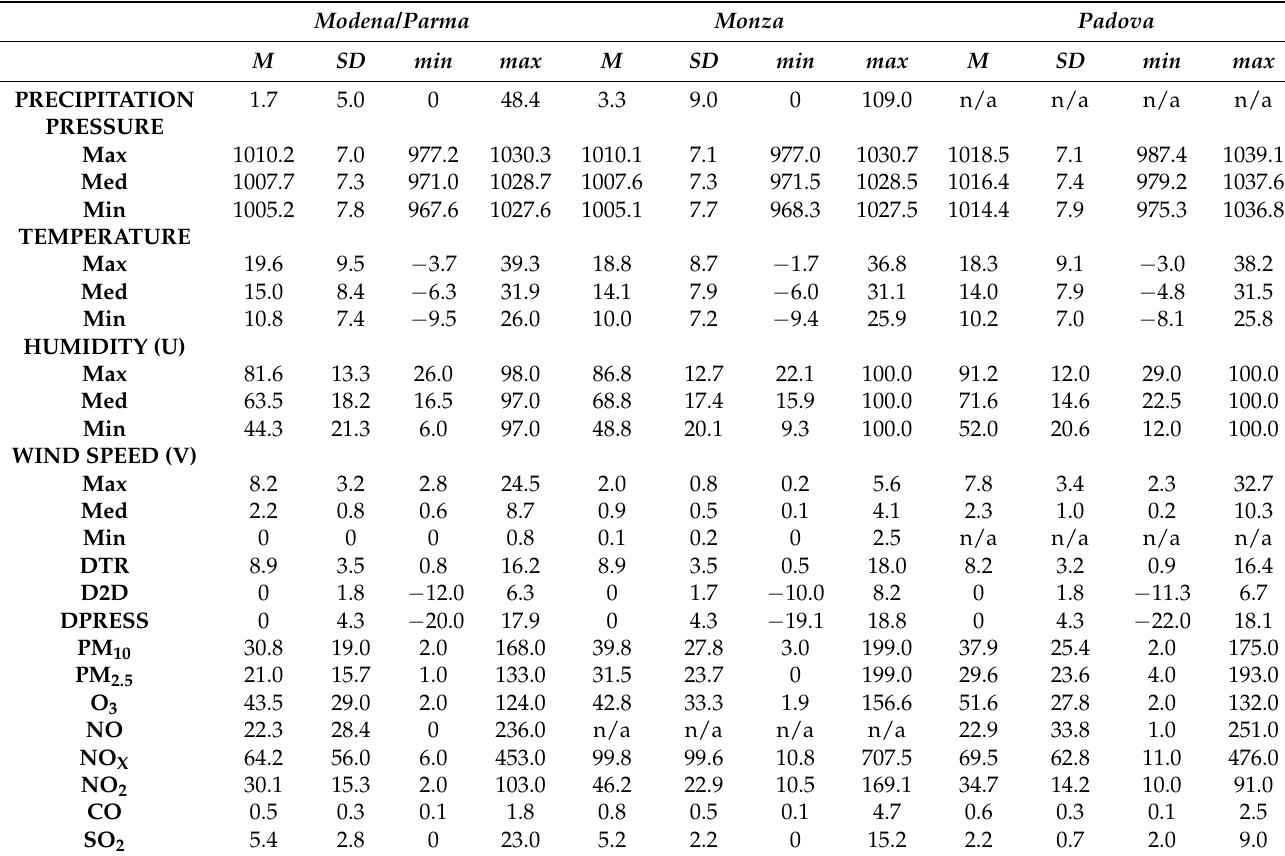
Table 1. Mean Value (“ M ”), standard deviation (“ SD ”), minimum (“ min ”) and maximum (“ max ”) of the distribution of meteorological and air quality variables considered in the meta-analysis as predictor of the hospitalization risk for SCD in the different centers. “N/A” indicates that the cor- responding values are not measured or available in the center. DTR: diurnal temperature range, D2D: day-to-day mean temperature changes, DPRESS day-to-day mean pressure changes, PM10: